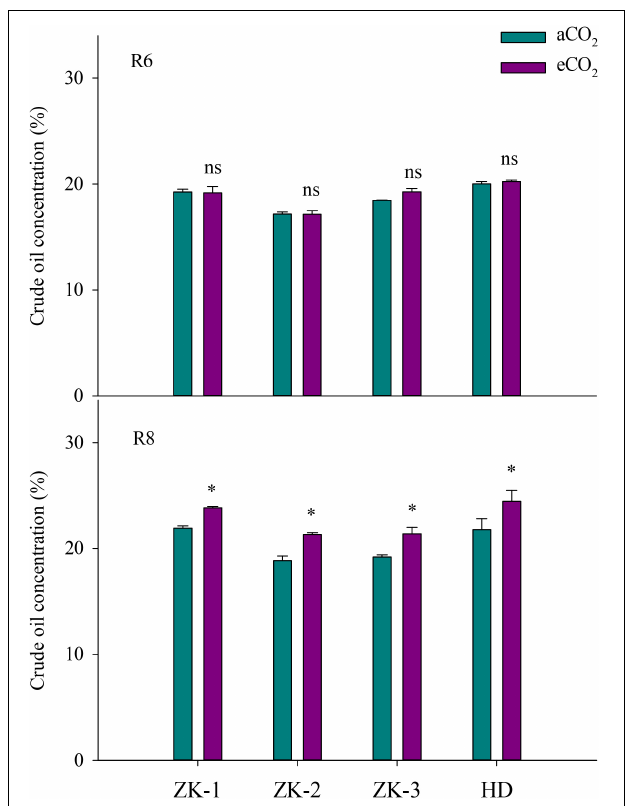
FIGURE 3 | Influence of elevated CO 2 on soybean seed oil concentrations at fresh edible (R6) and mature stages (R8) of four soybean cultivars: